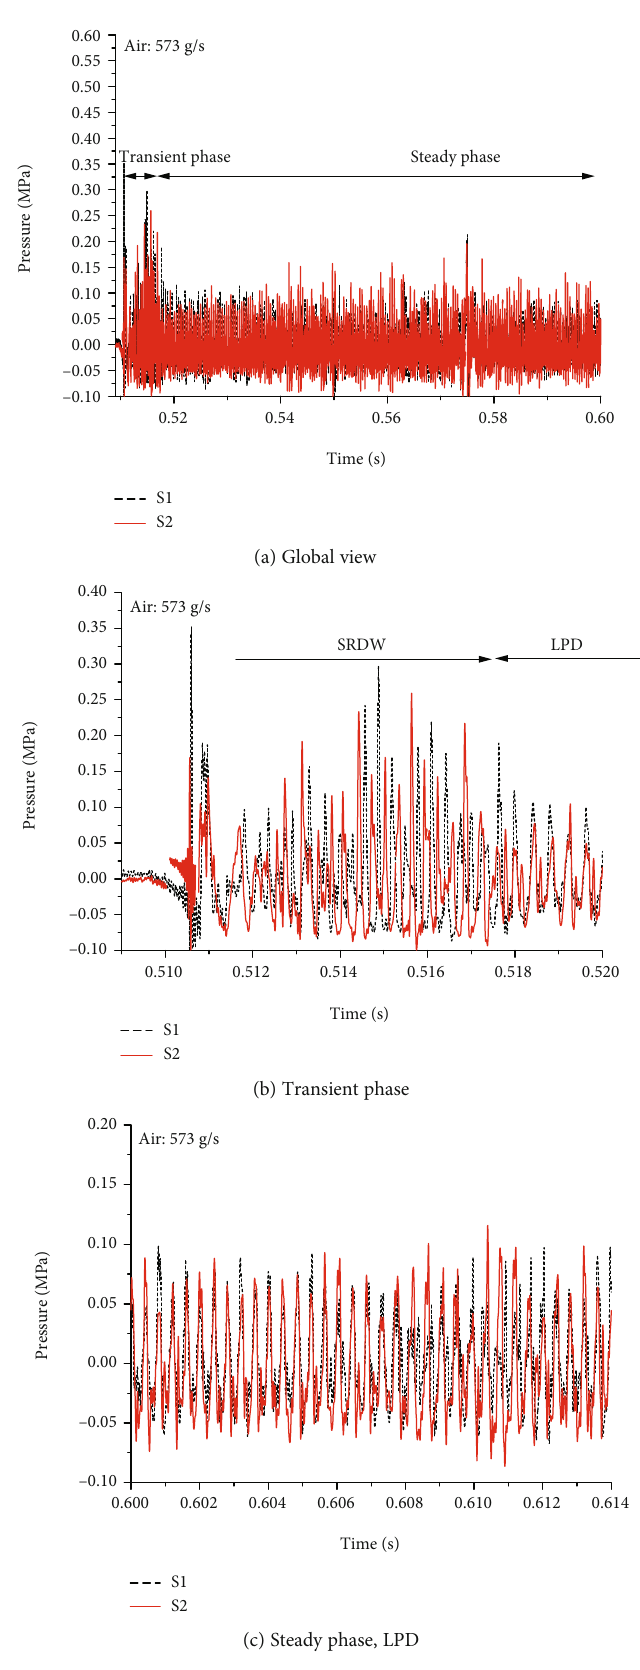
Figure 6: Pressure traces obtained by S1 and S2 for the air mass fl ow rate